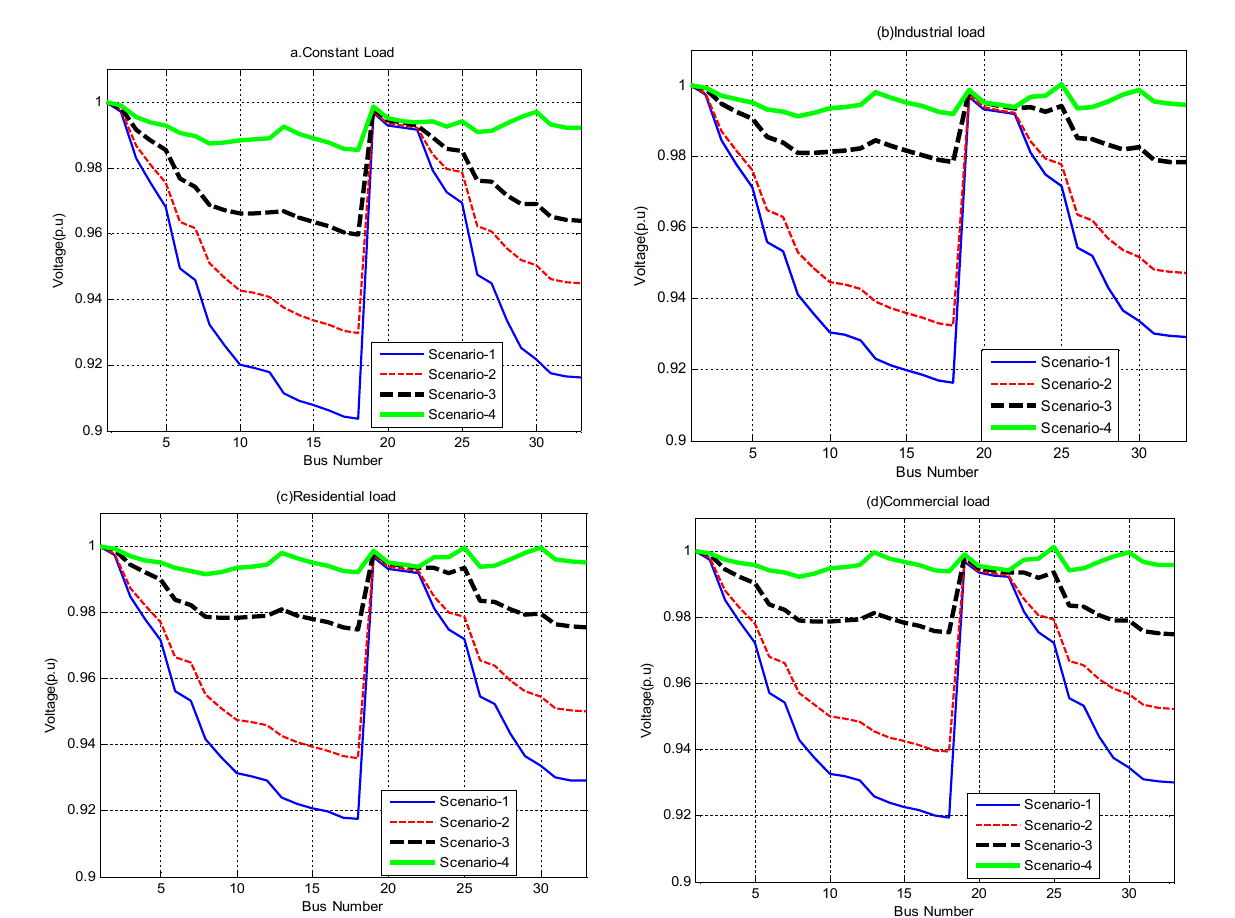
Figure 8. ( a ) Bus voltage comparison of IEEE 33-bus test system under constant load. ( b ) Bus voltage comparison of IEEE 33-bus test system under industrial load. ( c ) Bus voltage comparison of IEEE 33-bus test system under residential load. ( d ) Bus voltage comparison of IEEE 33-bus test system under commercial load.